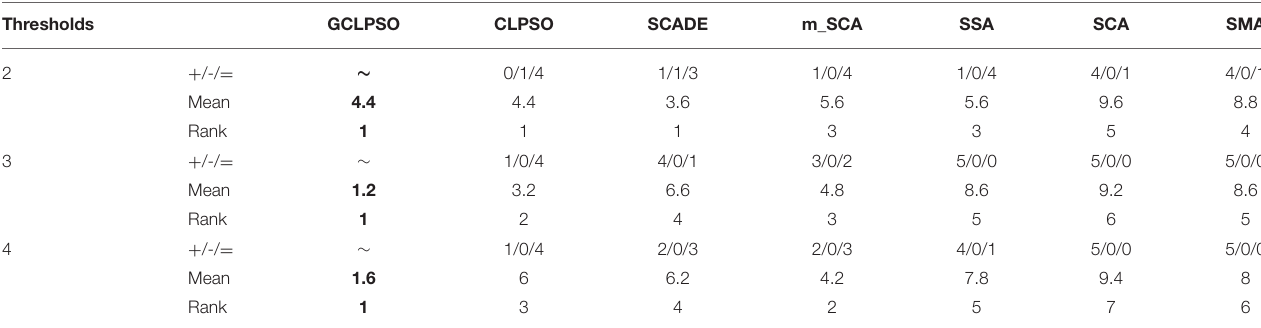
TABLE 9 | Results of the PSNR comparison by the Wilcoxon signed-rank test at each threshold level of maize rust disease. Thresholds GCLPSO